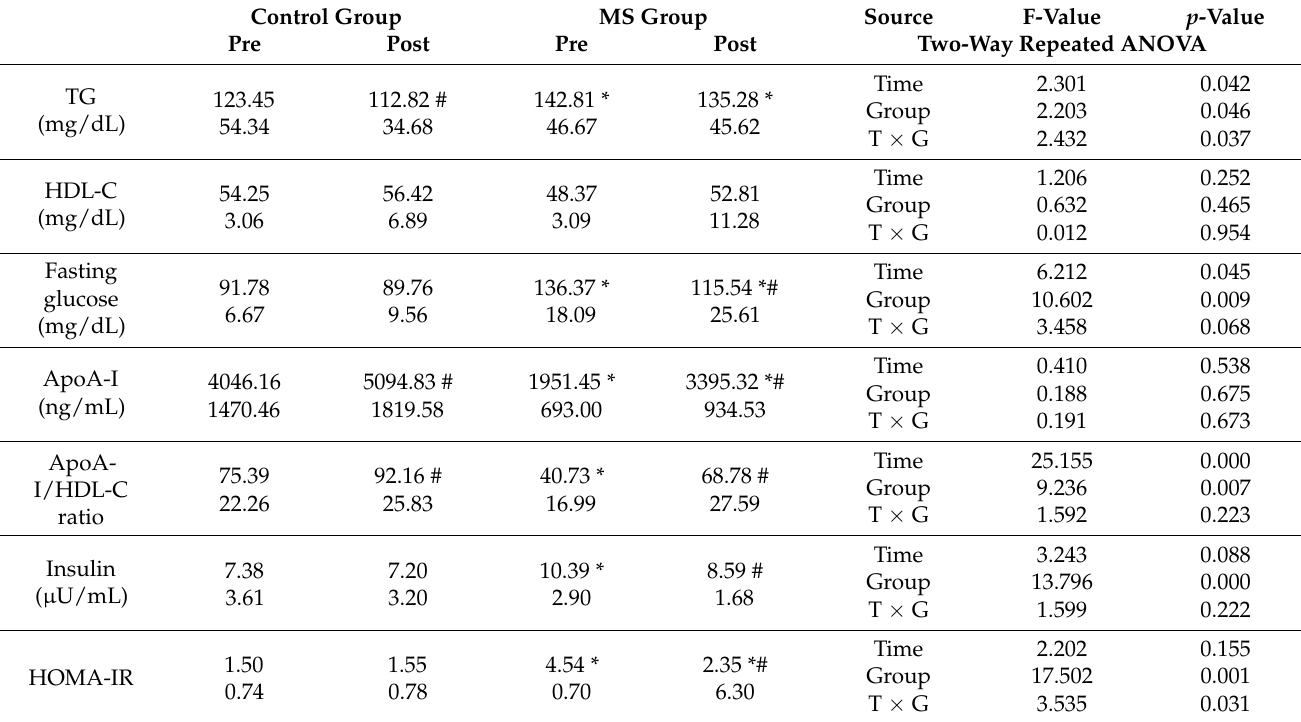
Table 3. Change of metabolic syndrome markers after exercise